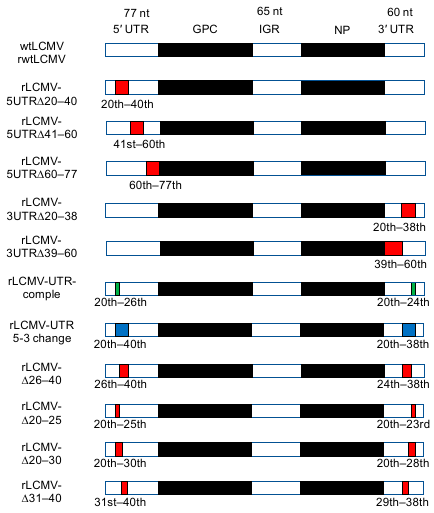
Figure 1. Schematics of the S segment of wildtype lymphocytic choriomeningitis virus (wtLCMV) and various mutated recombinant LCMVs (rLCMVs). The number above the region name (5 ′ untranslated region (UTR), intergenic region (IGR), and 3 ′ UTR) indicates the number of the nucleic acid in these regions. Red colored regions and the ordinal numbers described below indicate the deleted regions of S segment. Green colored regions and the ordinal numbers described below indicate the region which have complementary nucleic sequences of the relevant ordinal numbers. Blue colored regions and the ordinal numbers indicate the regions in which nucleic acid sequence of 5 ′ and 3 ′ termini are replaced by each other. All ordinal numbers are counted from either 5 ′ or 3 ′ termini, whichever is the nearest. The S segment structures of each virus names described on the left side of the schematics correspond to each schematic shown in the right side. The details on how each LCMVs were generated are described in the Plasmids subsection and in the Transfection, Minigenome, and Reverse Genetics System subsection in the Methods